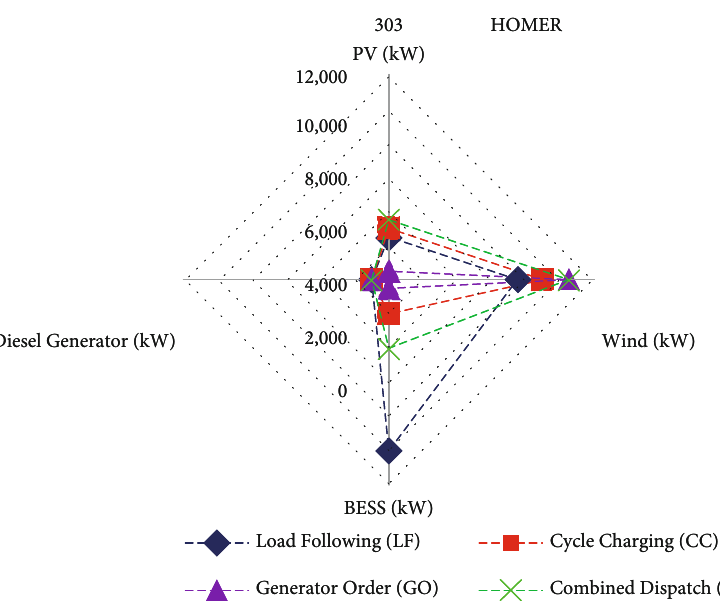
Figure 5: Optimal sizes of each module according to the various dispatch strategies for a proposed islanded hybrid microgrid in the HOMER platform. This fi gure is reproduced from Shezan et al. [5].